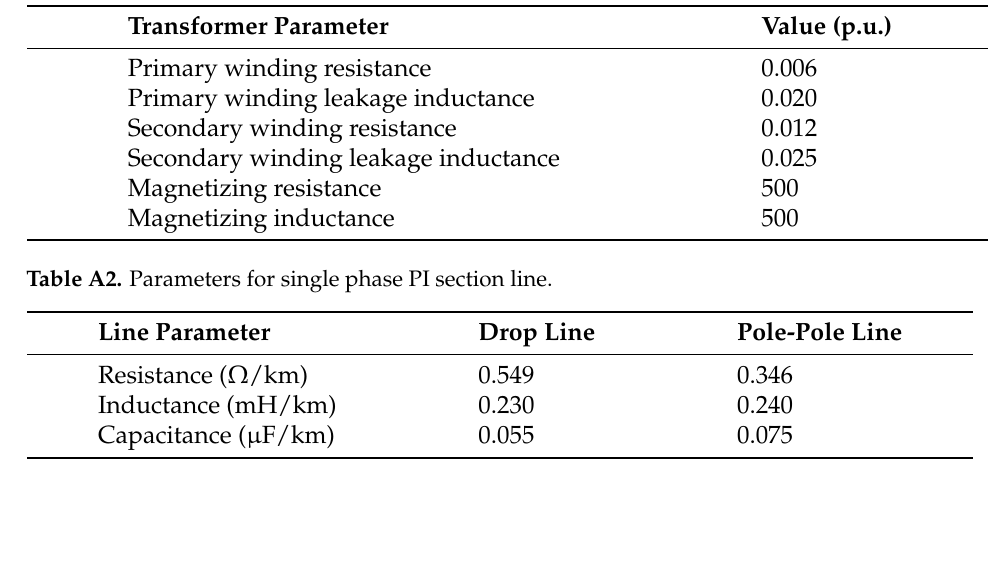
Table A1. Parameters for single phase LV transformer.